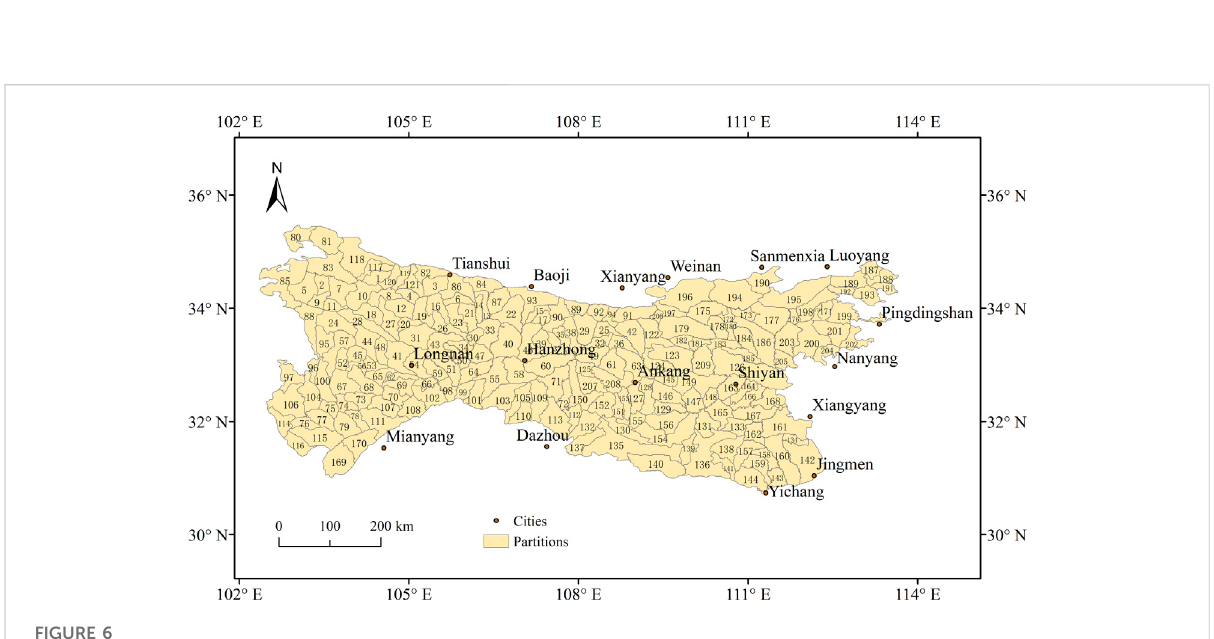
FIGURE 6 Catchment divisions (209) in the Qinling-Daba